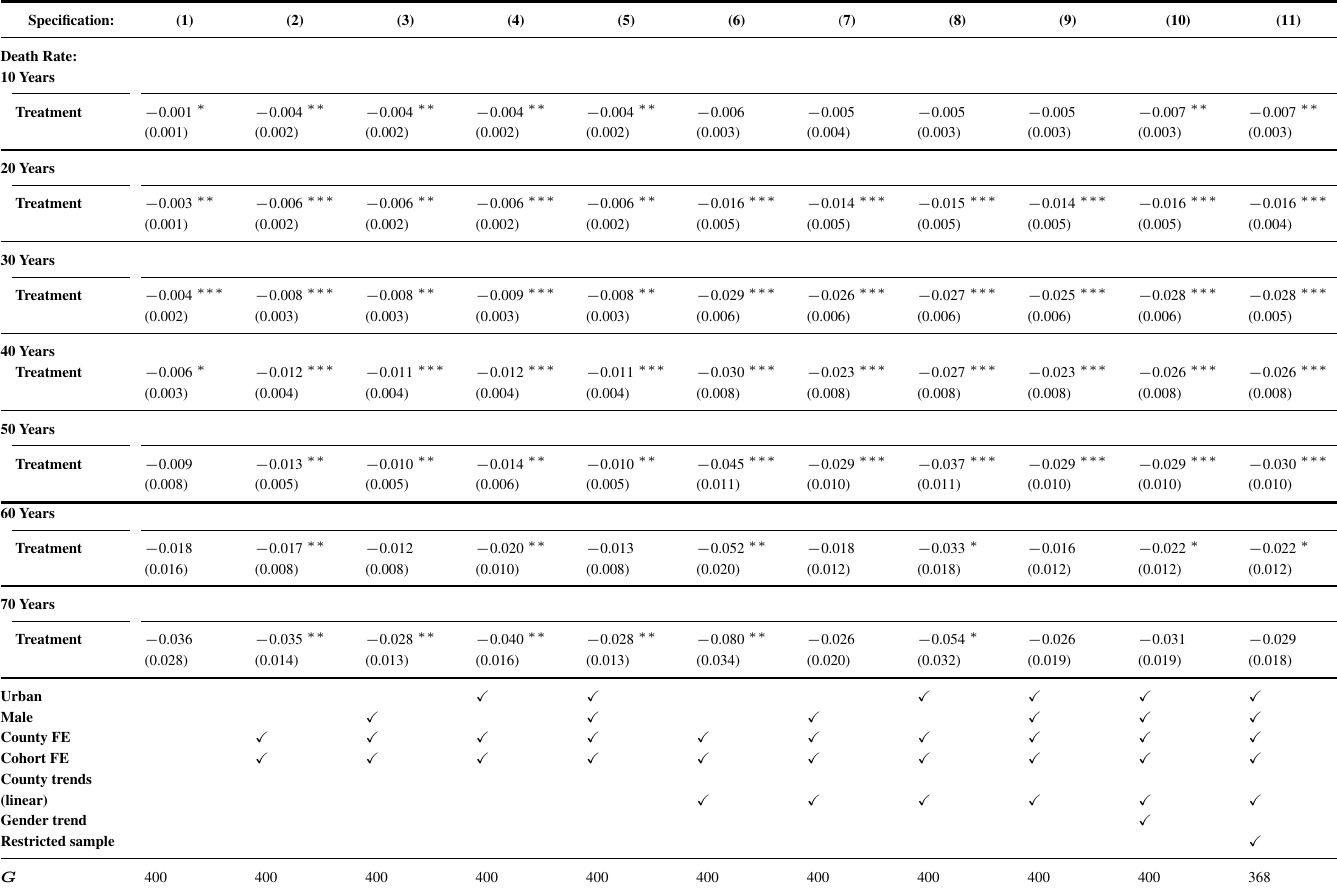
Table 4. Estimation results: different